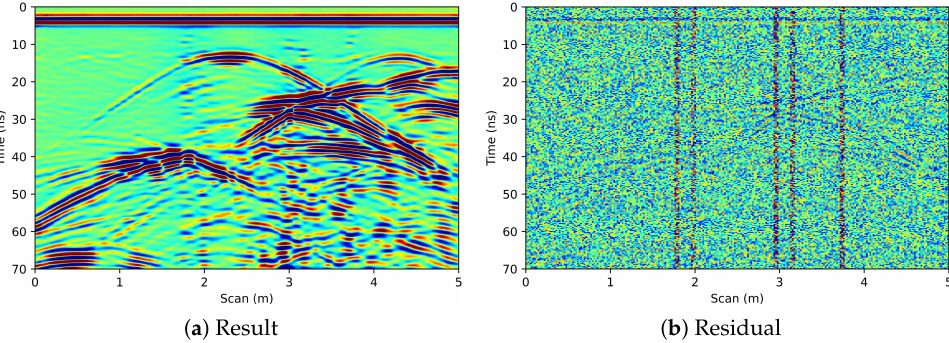
Figure 18. Noise attenuation results and residual for the GPR profile of the complex tunnel